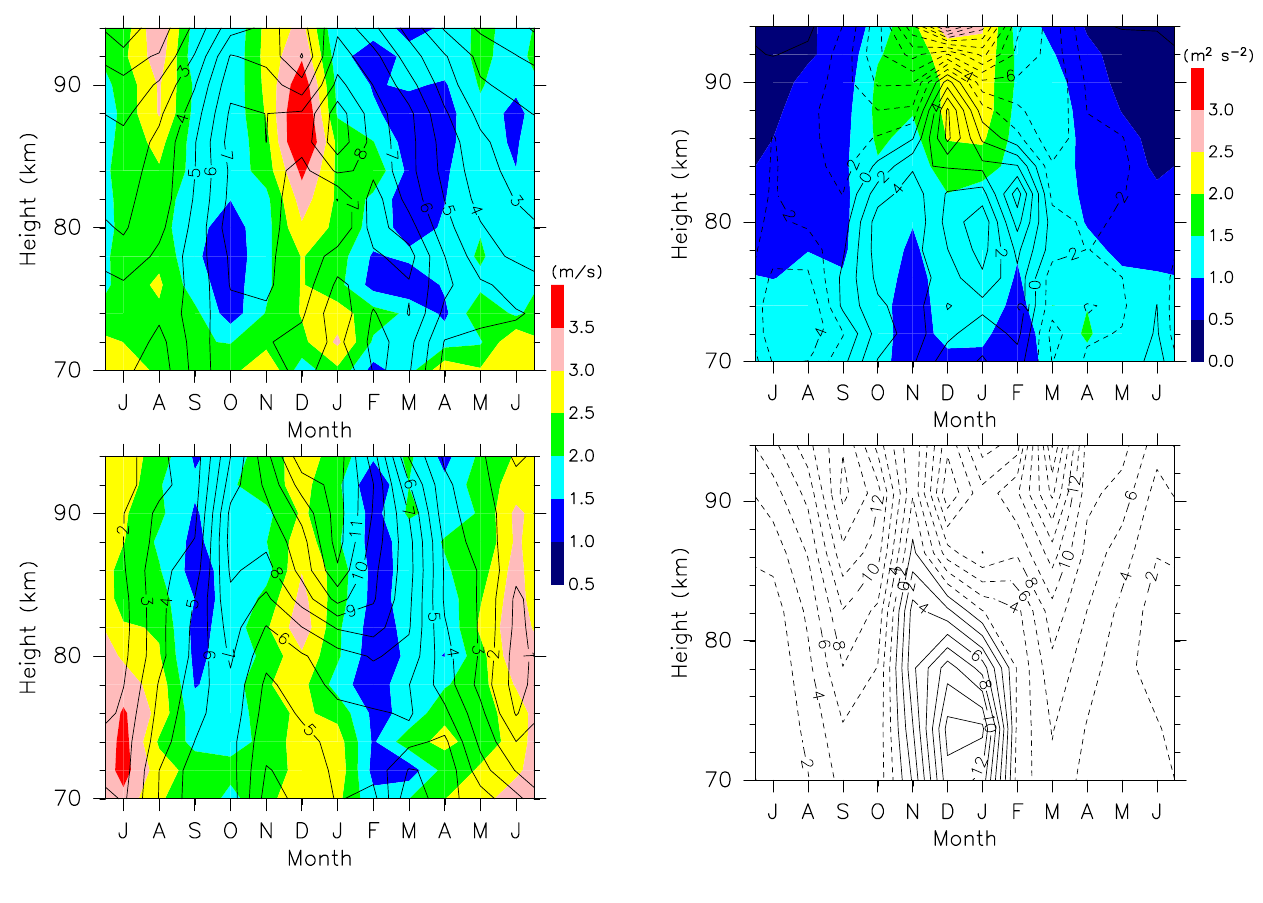
Fig. 4. Time-height sections of monthly-mean amplitudes (con- tours) of zonal (top) and meridional (bottom) winds with standard deviations (colors) of their interannual variations. Contour intervals are 1ms − 1 .